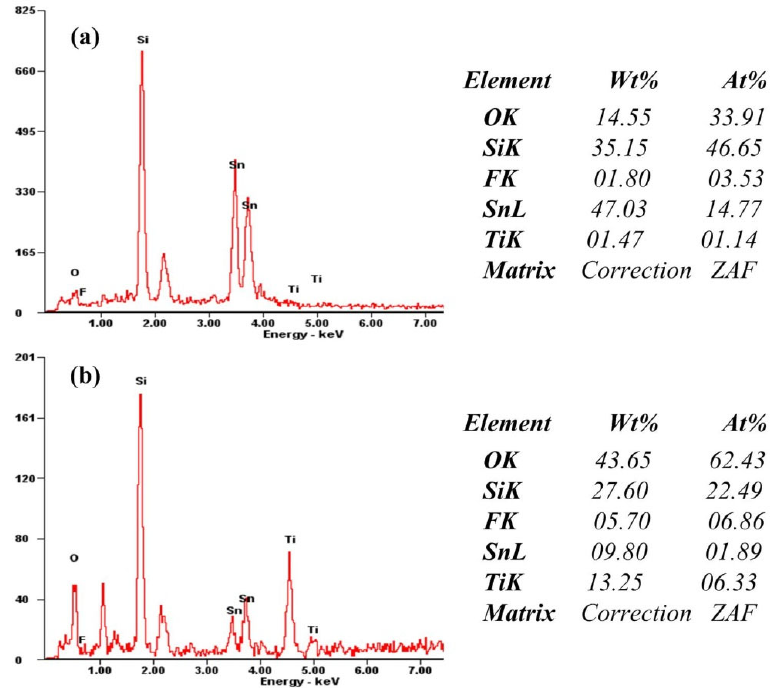
Figure 9. Front EDS spectrum ( a ) and cross ‐ section EDS spectrum ( b ) of the FTO substrate after adding barrier layer.